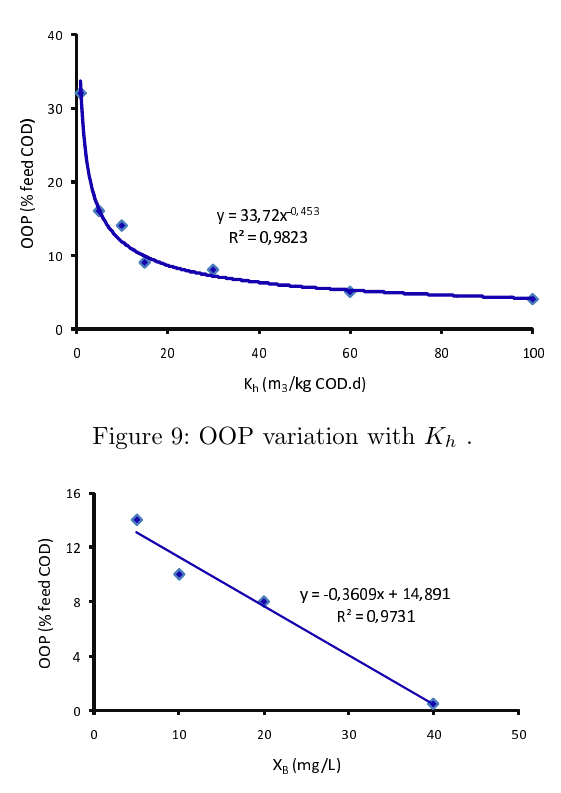
Figure 10: OOP variation with X B . holds a key role on deciding positive or negative oxy- gen